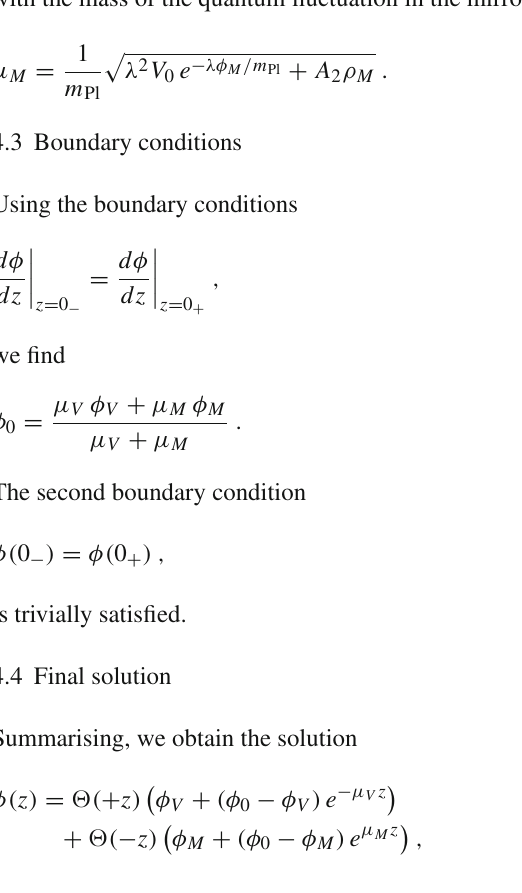
= 6 . 73 × 10 − 10 meV 4 H 2 Pl 0